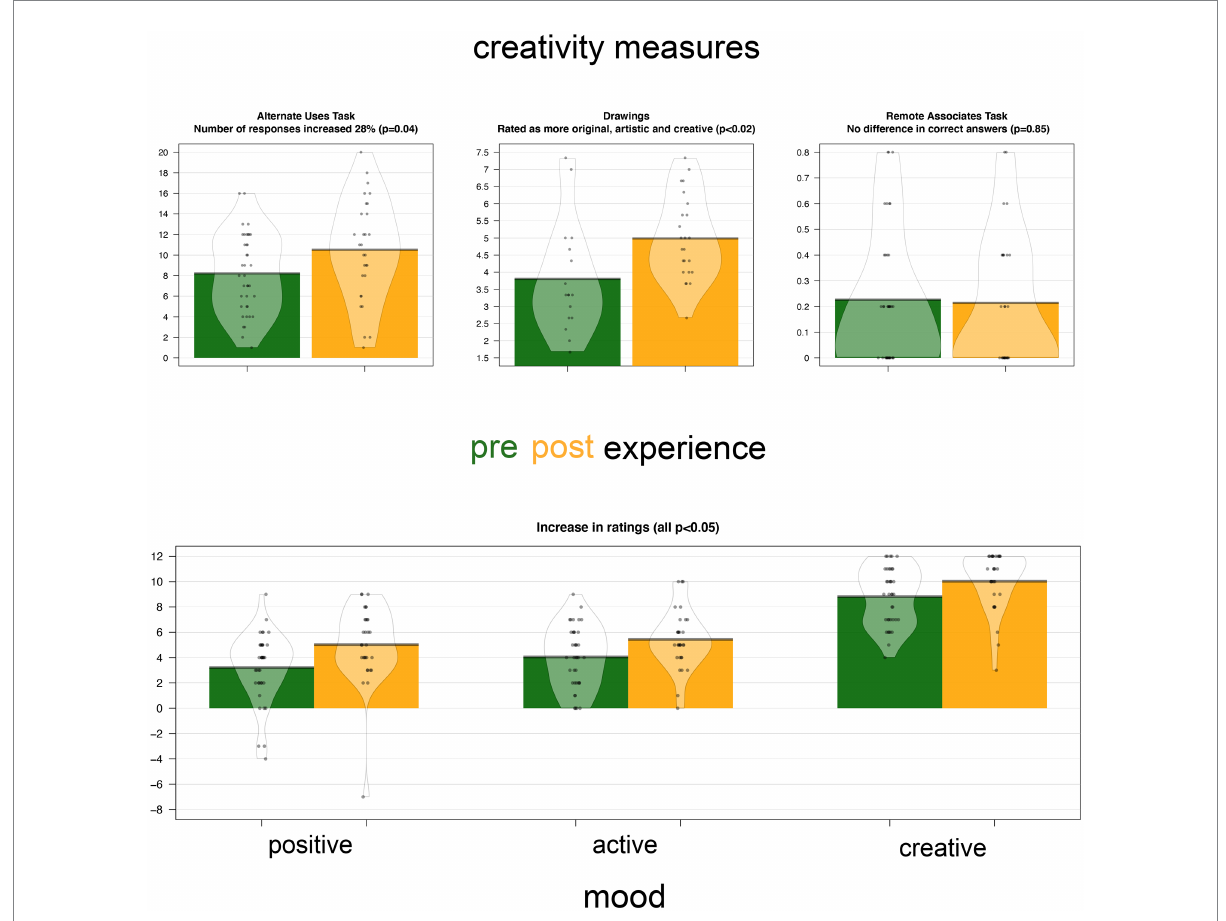
FIGURE 3 Creativity and mood measures, measure before and after underwater night club